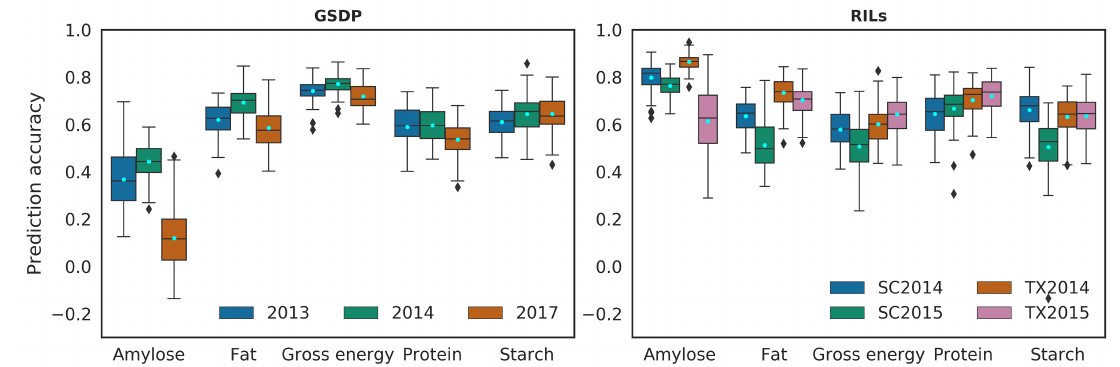
Figure 3. Prediction accuracy of Bayesian multi-output regressor stacking (BMORS) model using five-fold cross validation. Legend represents the years/environment. The y-axis shows prediction accuracy calculated as Pearson’s correlation between observed values and predicted values of phenotypes. SC: South Carolina, TX: Texas, GSDP: Grain sorghum diversity panel, and RILs: Recombinant inbred lines. Pale blue dots show mean of the prediction